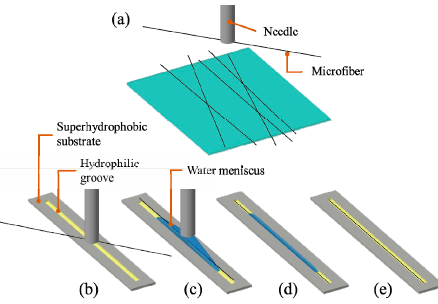
Figure 1. Schematic of surface tension-based alignment of a microfiber: ( a ) A microfiber is picked up by a needle; ( b ) The fiber is transport it to a target hydrophilic–superhydrophobic grooved surface; ( c ) The needle dispenses a drop of water and the water droplet is confined inside the hydrophilic groove; ( d ) The fiber is released from the needle and aligned to the groove; ( e ) The water droplet inside the groove evaporates. 2.2. Fabrication of Hydrophilic–Superhydrophobic Grooved Surfaces To fabricate hydrophilic–superhydrophobic grooved surfaces for alignment of microfibers, superhydrophobic coating (WHOLE-NANO SPN-62, WHOLE-NANO Ltd, Suzhou, China) was firstly sprayed on a 10 mm (length) × 10 mm (width) × 0.5 mm (thickness) silicon substrate and dried at room temperature, then an ultraviolet laser cutting machine LU-5 (HGTECH, Power of 5 W, Wavelength of 355 nm, Huagong Tech. Ltd, Wuhan, China) was used to fabricate microgrooves on the silicon substrate. The laser cutting machine was operated at the speed of 2000 mm/s, with the frequency of 1 00 kHz, the pulse width of 1 µs, and the current of 1 A. The width of the fabricated grooves was in the range of 100 µm–500 µm, the length of the groove was 4 mm, and the depth of the groove was around 35 µm. Microfibers used for the alignment test are glass fibers with a diameter of 13 µm and a length of 3.7 mm–4 mm. Figure 2 shows the glass microfiber and the fabricated grooved silicon substrate. Figure 2a,b represents the microscopic view of the glass fiber, and the diameter of the glass fiber is around 13 µm, which is about one fifth of a human hair in diameter. Figure 2c shows the fabricated grooved silicon substrate, where the size of the grooves is 4 mm (length) × 0.5 mm (width) × 0.035 mm (thickness). Figure 2d shows an image of the water contact angle (155°) on the superhydrophobic substrate. Figure 2e shows that the water contact angle in the groove is less than 5°.